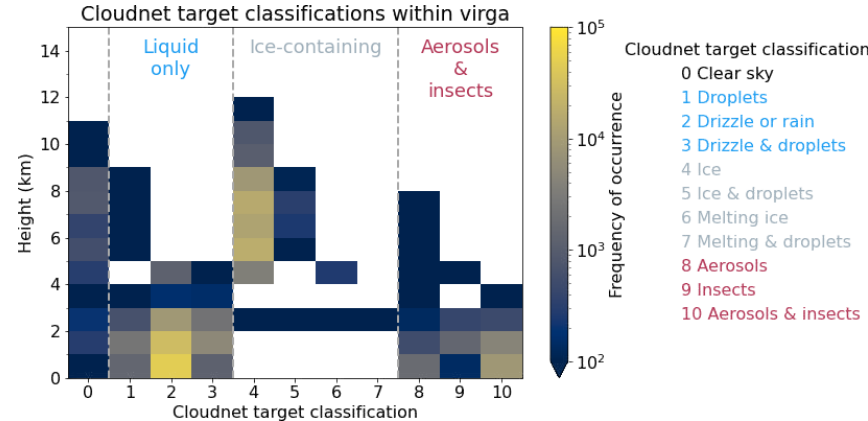
Figure 7. Height-resolved frequency of occurrence of the CloudNet target classification results within virga identified by the Virga-Sniffer. The target classes are grouped into three combined target classes: liquid-only, ice-containing, and aerosols and insects.